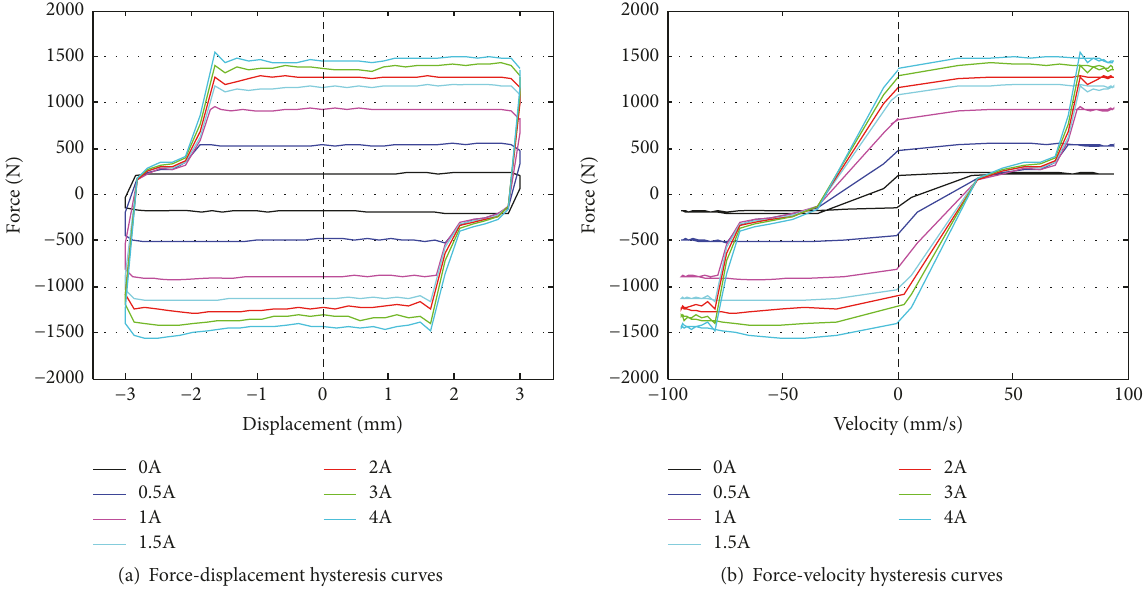
Figure 21: Hysteresis curves under different drive current at frequency of 5 Hz.